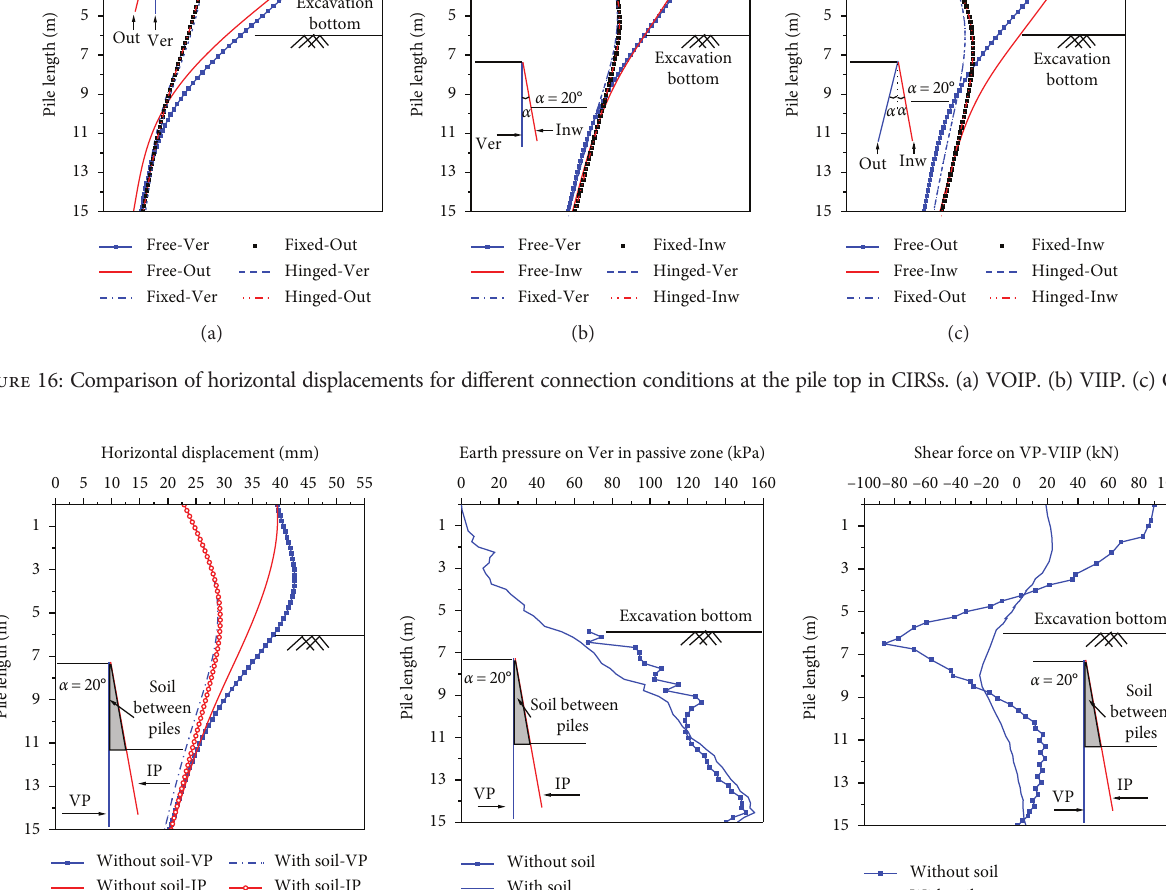
Without soil-VP With soil-VP Without soil-IP With soil-IP Figure 17: Comparison of VIIP with and without soil between retaining piles. (a) Horizontal displacements of VIIP. (b) Earth pressures acting on VIIP-VP in the passive zone. (c) Shear forces acting on